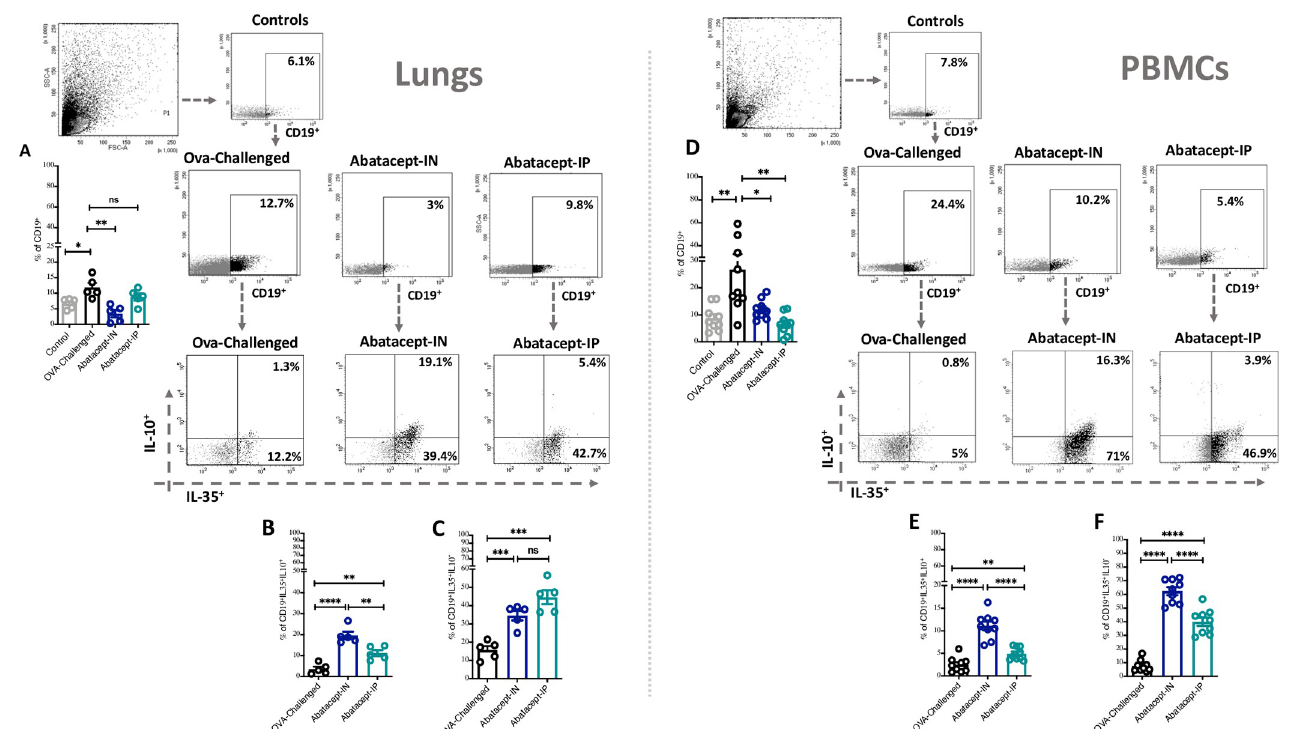
Fig 2. Abatacept enhances the levels of IL-35 + IL-10 + and IL-35 + producing CD19 + cells in lung tissues and peripheral blood of OVA- sensitized mice. (A) Percentage of CD19 + cells in the lung tissues of abatacept IN, abatacept IP treated, or OVA challenged mice, and in the normal control mice. (B-C) Percentage of IL-35 + IL-10 + producing B cells and IL-35 + producing B cells in the lung tissues of abatacept IN, abatacept IP treated, or OVA challenged mice. (D) Percentage of CD19 + cells in the PBMCs of abatacept IN, abatacept IP treated, or OVA challenged mice, and in the normal control mice. (E-F) Percentage of IL-35 + IL-10 + producing B cells and IL-35 + producing B cells in the PBMCs of abatacept IN, abatacept IP treated, or OVA challenged mice. Lung tissues of 5 mice and PBMCs of 10 mice were used. Two-way unpaired t-test was used to calculate significance. � ��� P < 0.001. Events were recorded and analysed by using BD FACSDiva version